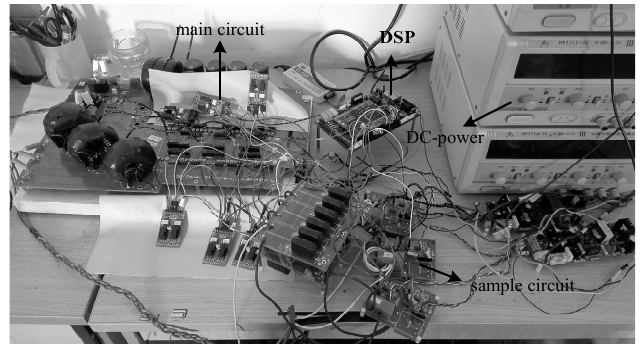
Figure 18. Experimental platform. Algorithms 2018 , 11 , x FOR PEER REVIEW